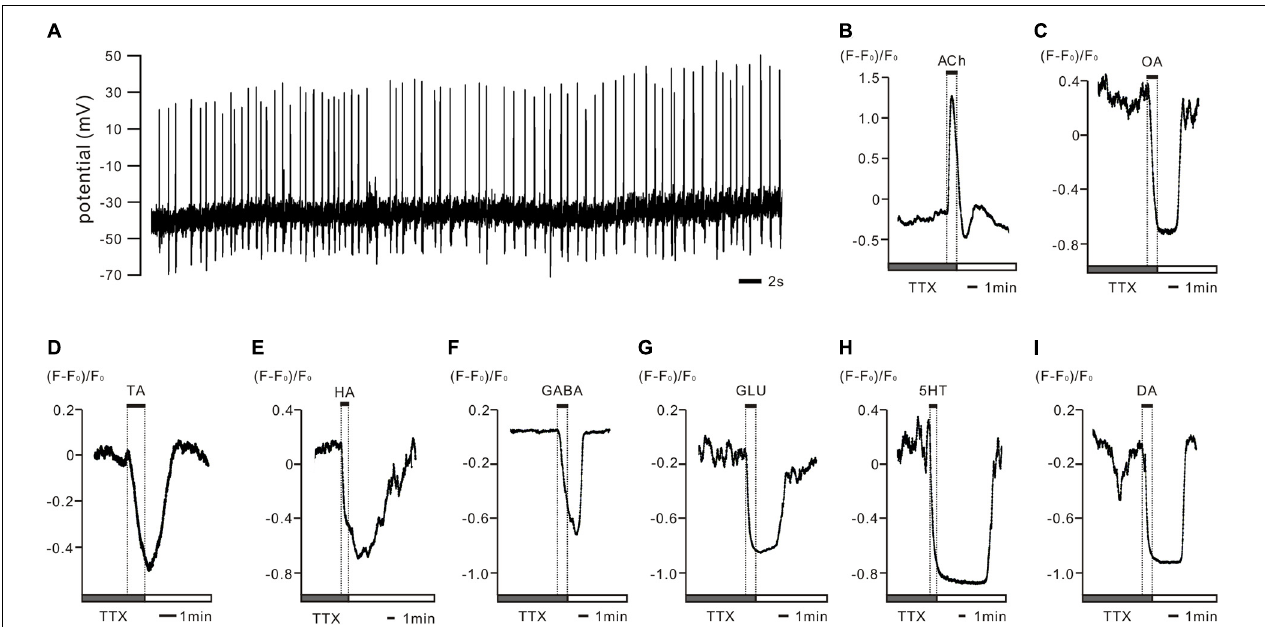
FIGURE 1 | In vivo recorded PTTH neurons displayed spontaneous activity patterns and were shown to be regulated by various neurotransmitters in ex vivo preparations of Drosophila larval brains. (A) The representative whole cell patch clamp recording trace of PTTH cell in vivo shows spontaneously firing action potentials (APs) throughout the day. All PTTH neurons recorded presented a tonic firing pattern at a frequency of 1.26 ± 0.14 Hz ( n = 15). (B–I) Representative delta F / F traces of Ca2+ responses in GCaMP6m-expressing PTTH neurons after tetrodotoxin (TTX) disrupted AP-dependent synaptic transmission. Application of 1 mM acetylcholine ( ACh) to the bath solution resulted in increased intracellular Ca 2 + concentrations ( n ACh = 10), whereas octopamine (OA), tyramine (TA), histamine (HA), γ -aminobutyric acid (GABA); glutamate (GLU), serotonin (5-HT) and dopamine (DA) decreased intracellular Ca 2 + levels in all of the imaged PTTH cells ( n OA =